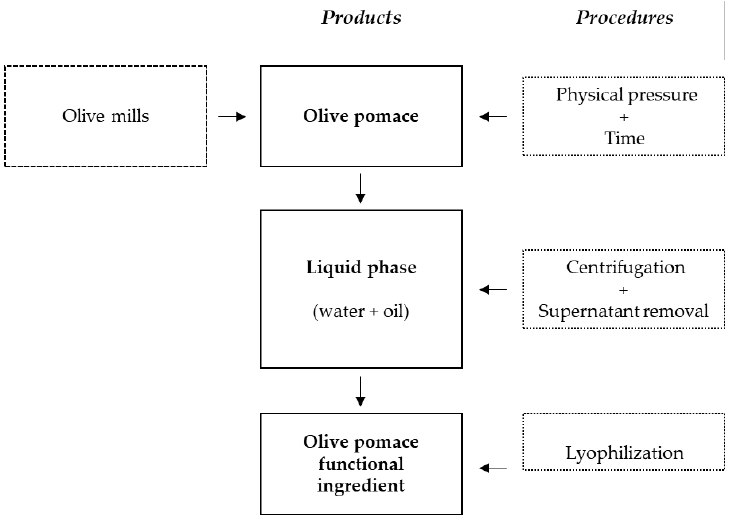
Figure 1. Obtention of the olive pomace functional ingredients.